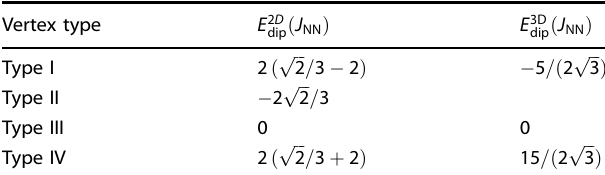
Table 1. Dipolar interaction energies in each vertex type in 2D and 3D ASI in units of J NN , which is J NN ≈ 0.43 eV for the chosen material and geometry